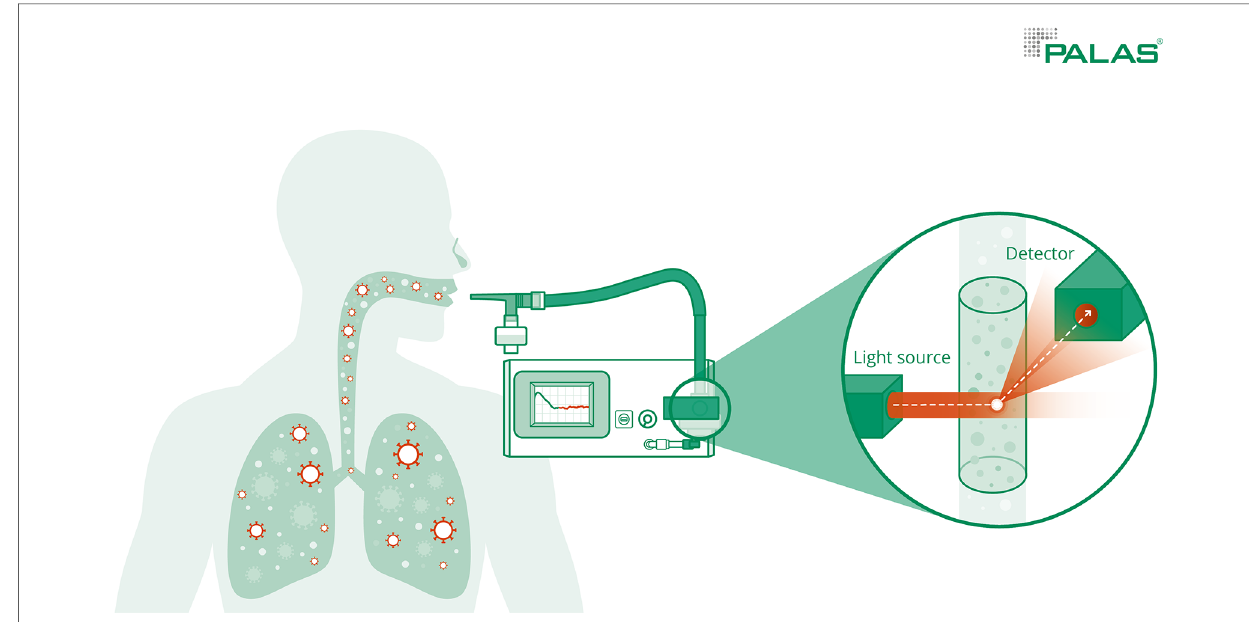
FIGURE 1 Measurement of aerosols. Measurement of the exhaled particle concentrations and size distribution was performed using the Resp-Aer-Meter using the principle of optical light